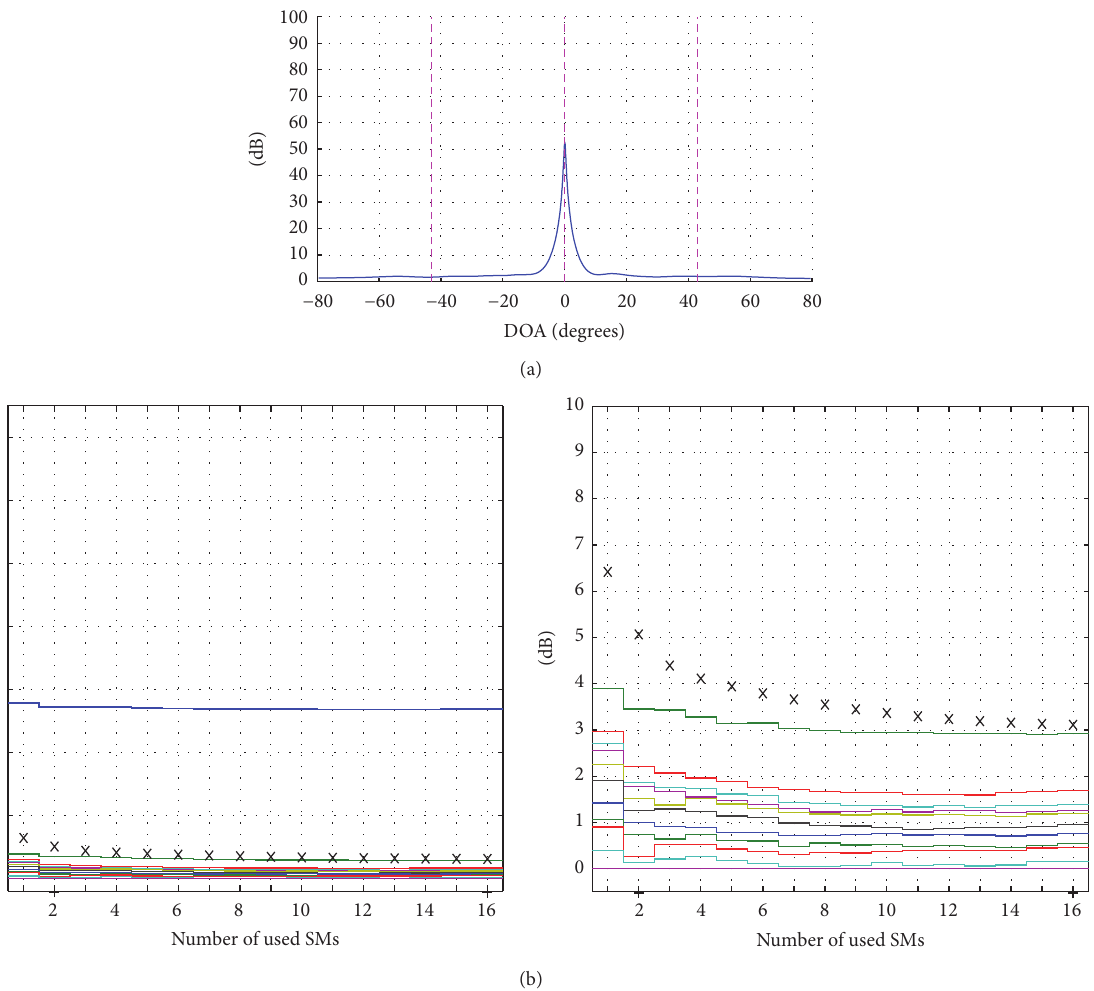
Figure 12: Measurement C1W. A single weak transmitter. (a) Capon DOA spectrum. (b) Eigenspectrum. Zoom-in to the right. dB scale. See Section 3.3 for